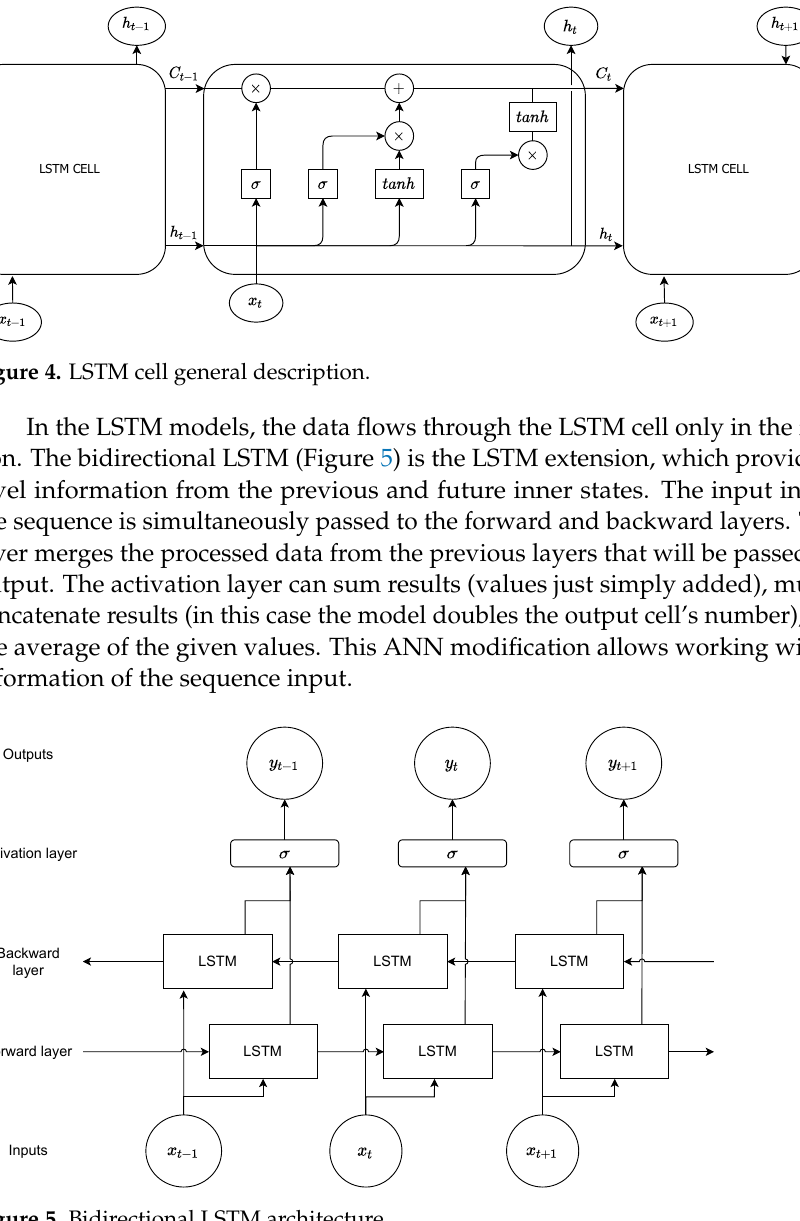
Figure 5. Bidirectional LSTM